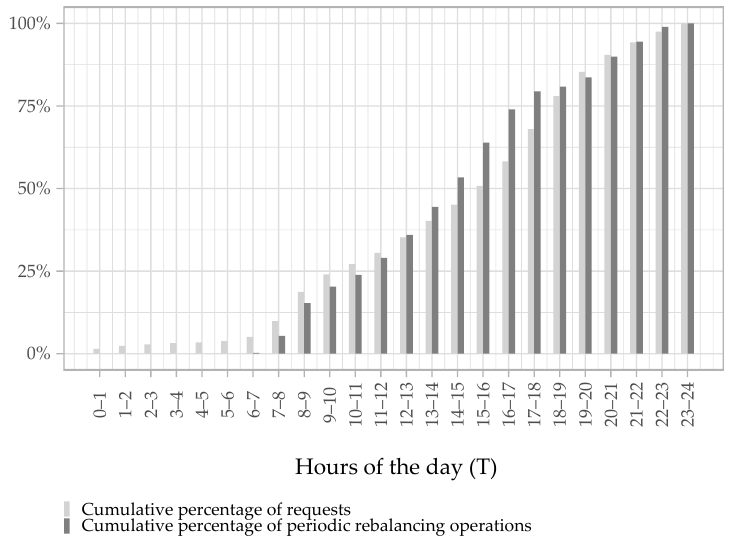
Figure 5. Evolution of demand and rebalancing operations during the day.